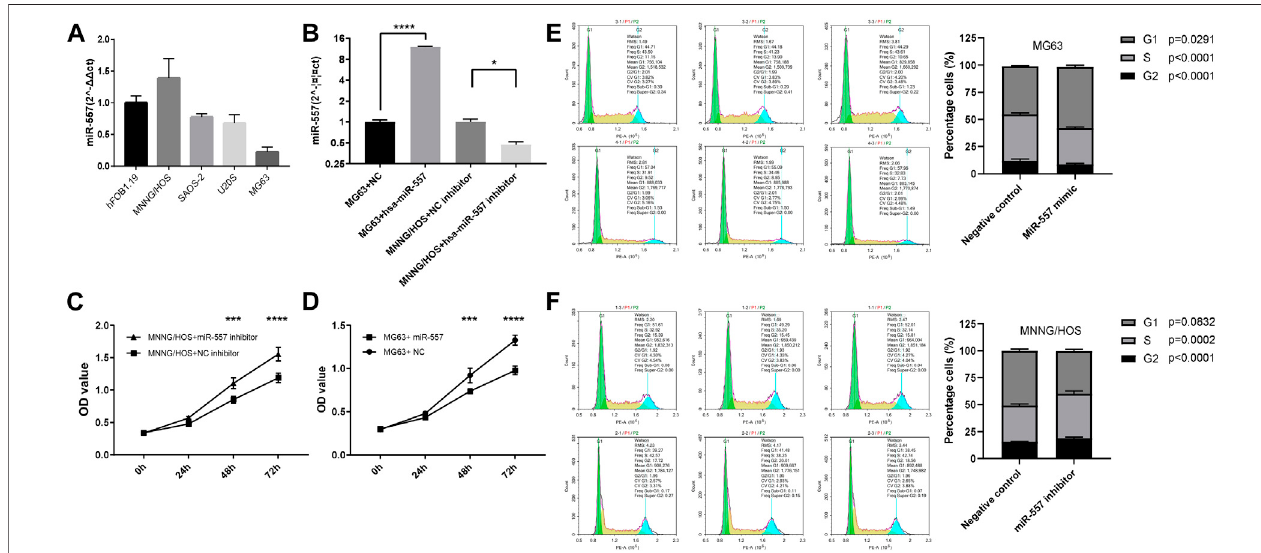
FIGURE 2 | Hsa-miR-557 inhibits the proliferation of osteosarcoma cells in vitro . (A) Hsa-miR-557 expression in osteosarcoma cell lines (MNNG/HOS, SAOS-2, U20S, and MG63) and normal osteoblasts (hFOB1.19). (B) Successfully elevated hsa-miR-557 expression levels by hsa-miR-557 transfection in MG63 and inhibited hsa-miR-557 expression levels by hsa-miR-557 inhibitor transfection in MNNG/HOS. (C,D) CCK-8 assay showed that Hsa-miR-557 inhibited MG63 cell proliferation, and hsa-miR-557 inhibitor could promote MNNG/HOS cell proliferation. (E,F) Cell cycle analysis showed that comparing with the NC, hsa-miR-557 inhibited the proliferation of MG63 cells ( p (cid:1) 0.0008, t (cid:1) 8.999), and inhibition of hsa-miR-557 promoted MNNG/HOS proliferation ( p (cid:1) 0.0001, t (cid:1) 14.62) (* p < 0.05, *** p < 0.001, **** p <